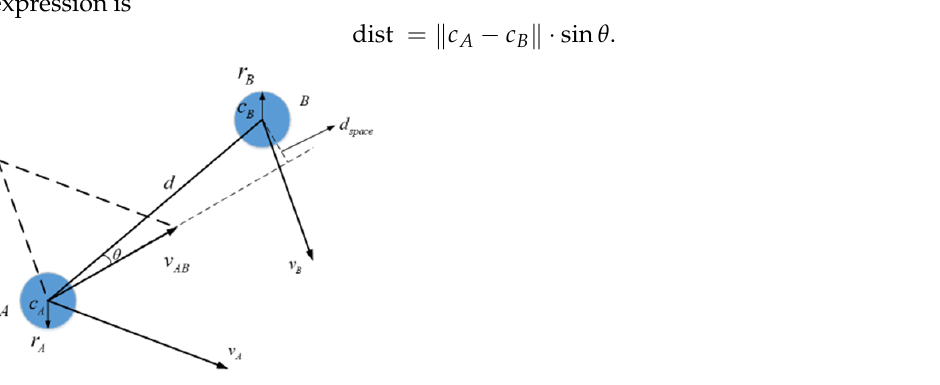
Figure 5. Velocity gap schematic